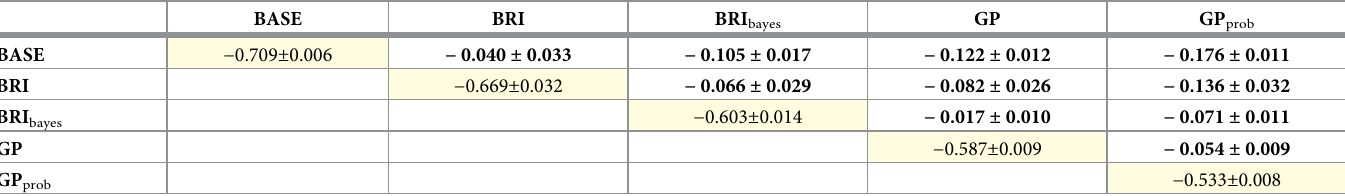
Table 2. Model performance on toy data set.